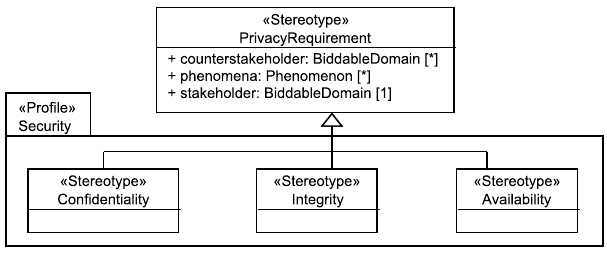
Figure 15. Used Taxonomy of Security